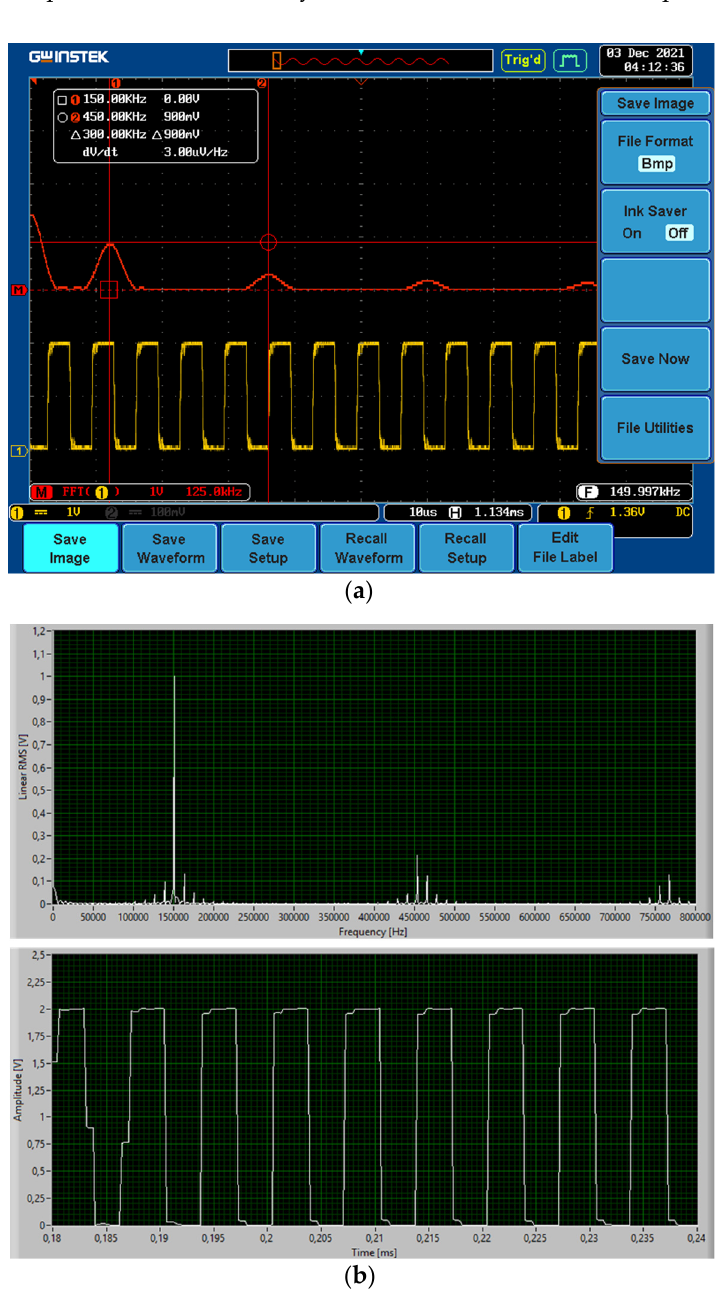
Figure 18. Tested rectangular signal with amplitude 2 Vp-p and offset 1 VDC, with fundamental frequency of 150 kHz. ( a ) Measured using a calibrated oscilloscope (Gwinstek GDS-2102A); ( b ) Measured using the custom FPGA-based system. Table 2. Comparisons between the calibrated oscilloscope and the FPGA-based system measure- ments for sinusoidal signals with amplitude of 5 Vpp with 2.5 VDC offset value, for signal fre- quencies of 15 kHz, 60 kHz and 150 kHz.